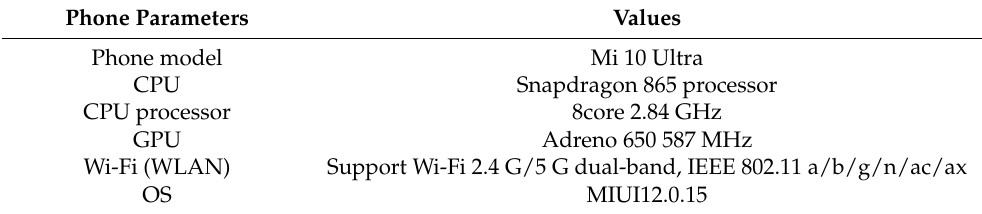
Table 1. Experimental equipment